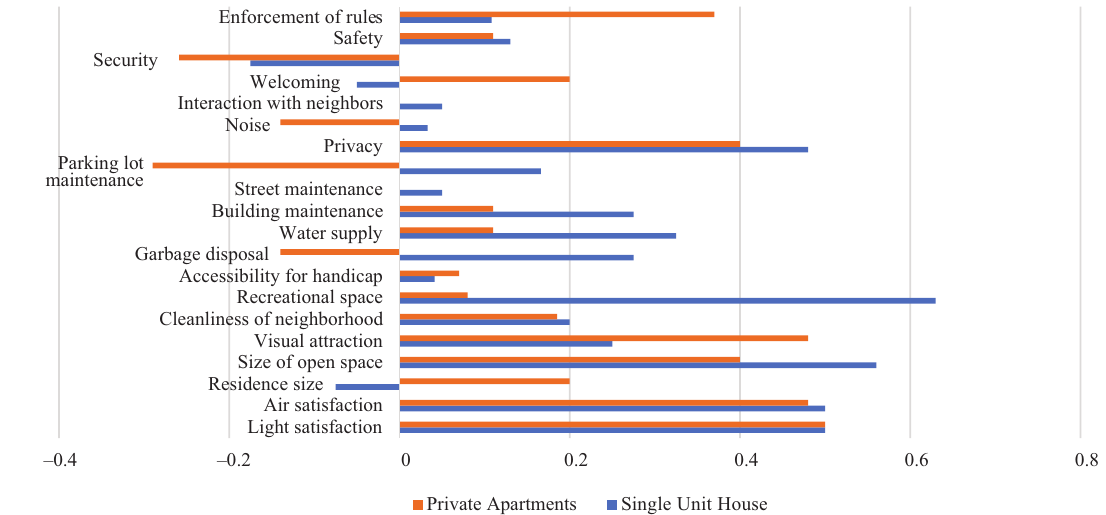
Figure 8. Satisfaction with respect to housing type (source: field